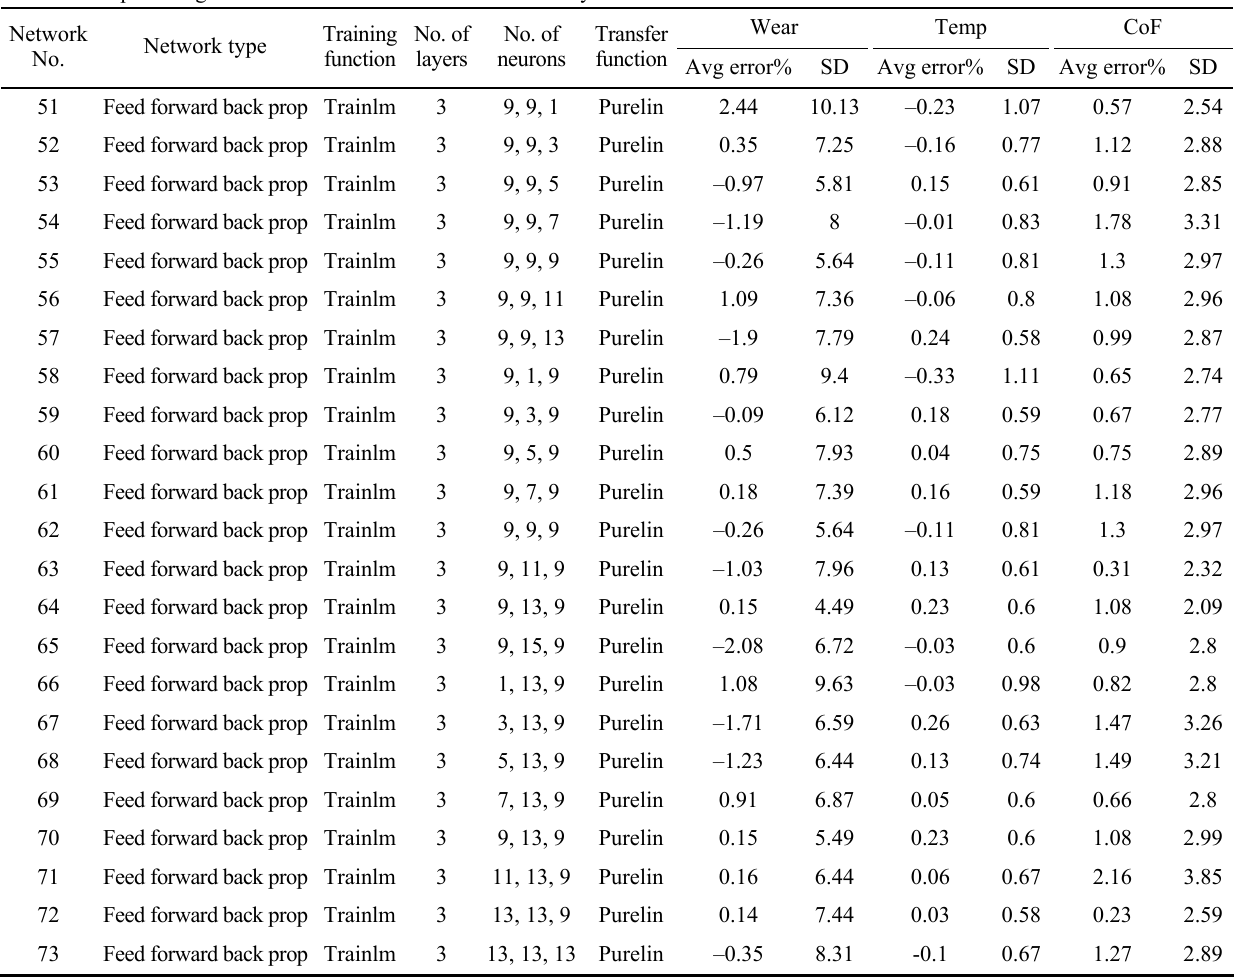
Table 19 Optimizing the number of neurons in multi hidden layers.